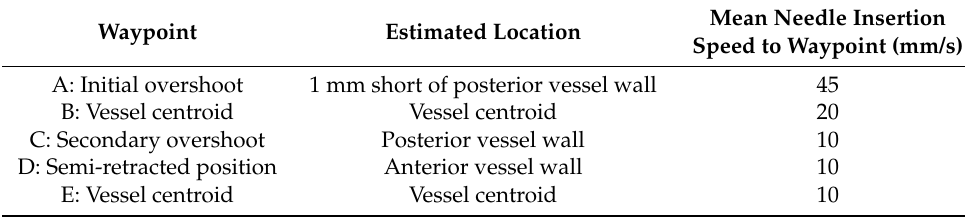
Table 2. Needle insertion waypoints and insertion speeds.